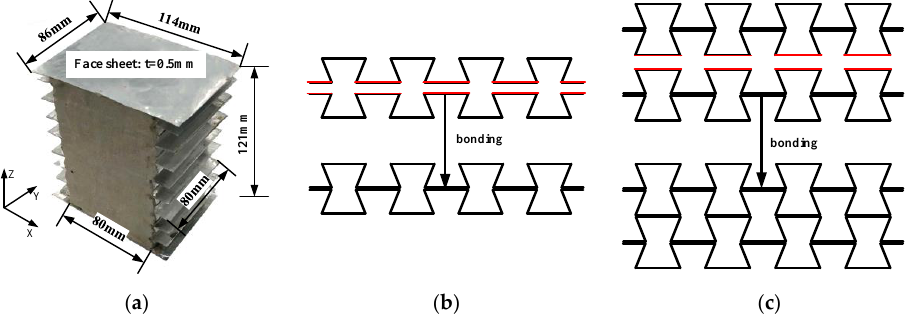
Figure 1. The auxetic honeycomb filled with foam concrete: ( a ) the specimen photo; ( b ) illustration of joining corrugated sheets to form auxetic honeycomb cells; ( c ) illustration of joining lines of cells to form auxetic honeycomb part. In ( b , c ), the edges in red were joined by adhesive.